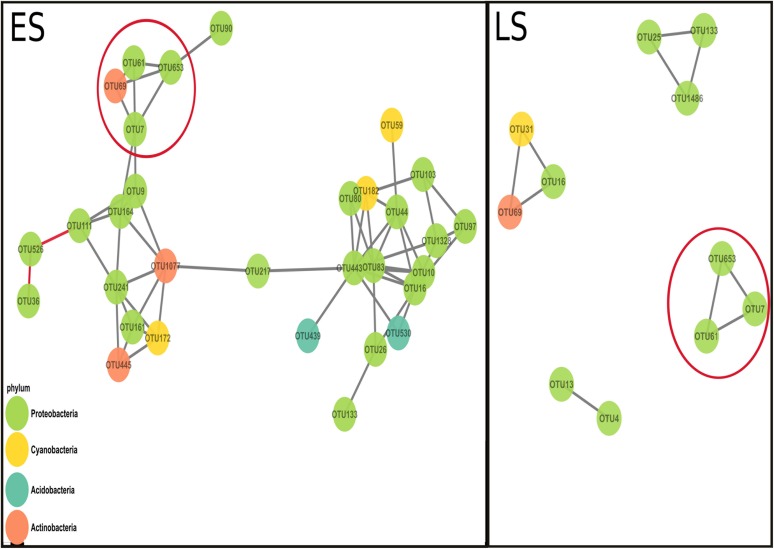
Co-variance networks built from the OTU normalized counts from early spring (ES) and late spring (LS). Each dot represents an OTU (the colors represent different phyla) and each black line represents a positive co-variance (considered as a surrogate of cooperation) and the two red lines in the ES networks represent two negative co-variances (interpreted as a possible competitive interaction). The red circles highlight the interactions that both networks shared. The average connectivity (average amount of positive co-variance a node possesses in a network) is higher in the ES network (=4) compared to the LS network (=1.82). The modularity was higher in the LS network (0.72) than in the ES network (0.532).